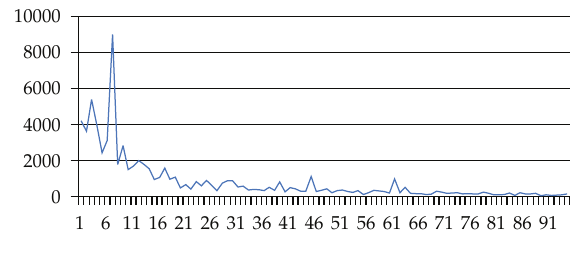
Figure 3: The time series of rehabilitation group Fugle-Meyer baseline unit cost e ff ectiveness.